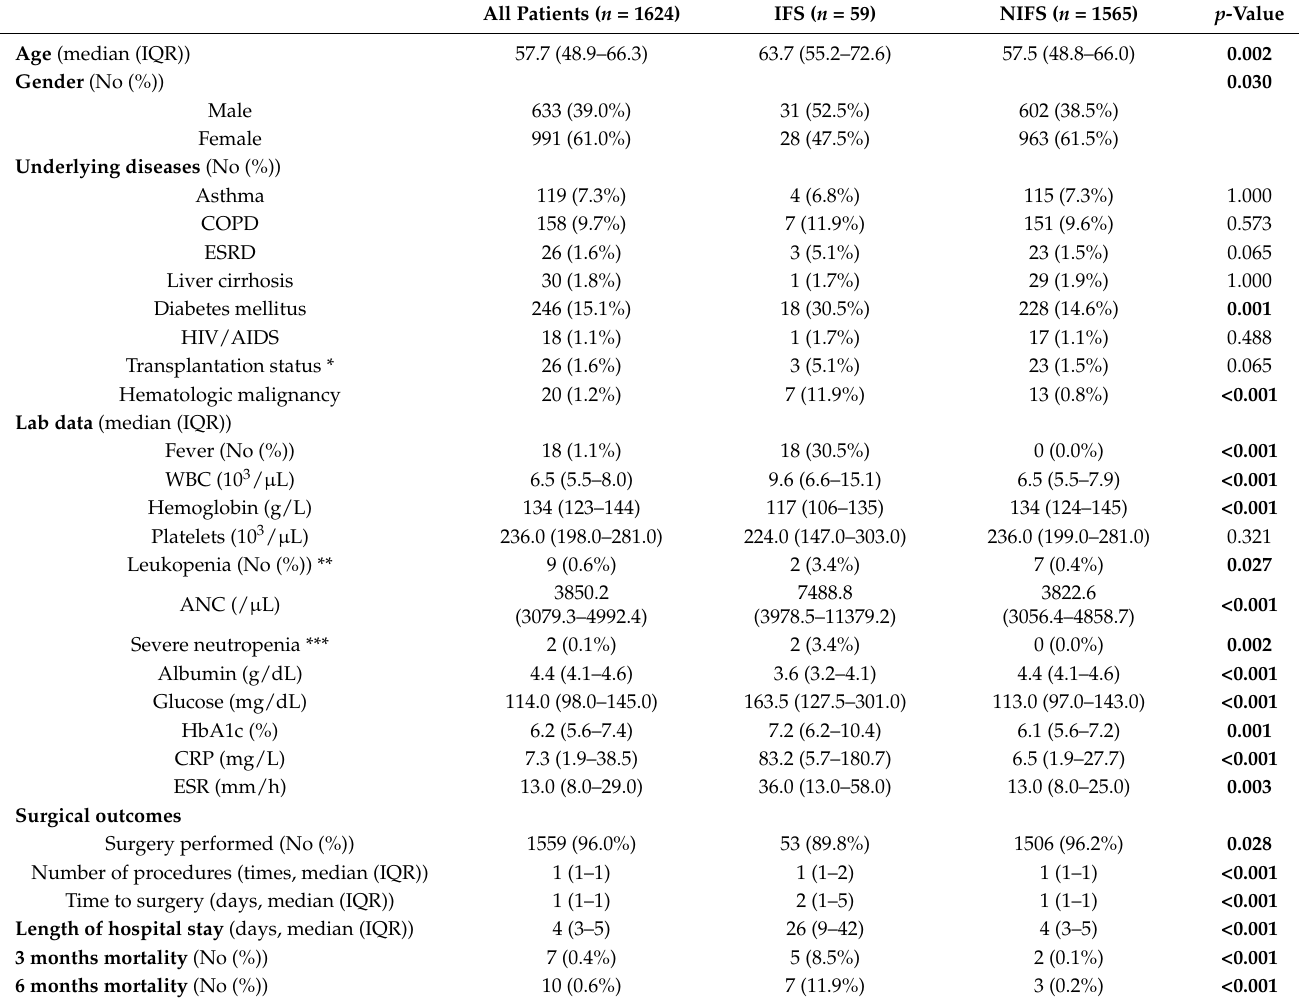
Table 1. Demographic data, laboratory results, surgical outcomes, morbidity, and mortality between the IFS and NIFS